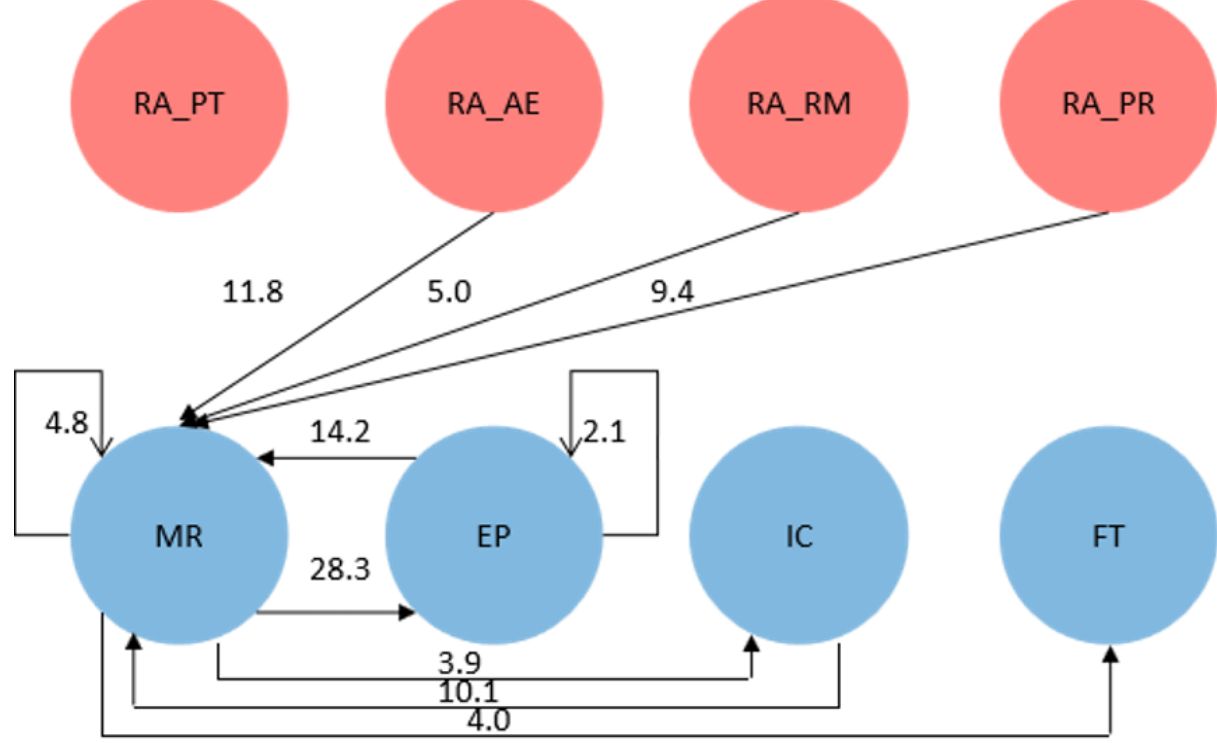
Figure 6. Behavior transition graph for the digital multiplayer serious game. AE: activity executions; EP: edit profiles; FT: finish tasks; IC: invite cooperation; MR: manage resources; PR: production resilience; PT: production throughput; RA: receiving update; RM: resource